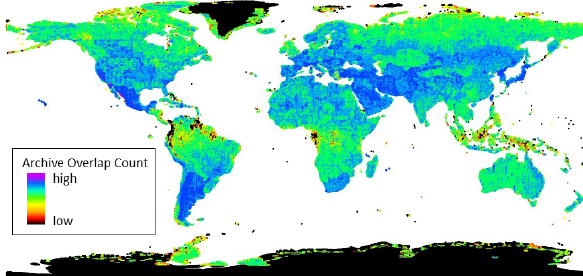
Figure 3. SPOT 6/7 image archive overlap count, from 2013 to mid-2019 with less than 15% of cloud cover over the